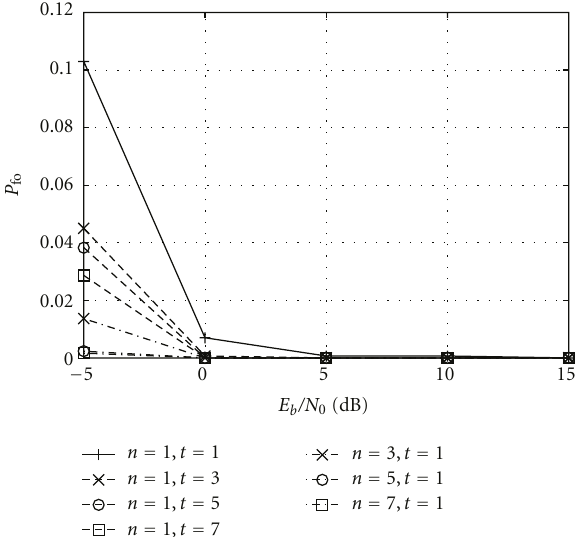
Figure 8: Probability of false opportunity detection P fo versus energy per bit to noise power spectral density ratio E b /N 0 for di ff erent numbers n of cooperative single antenna CR terminals and multiple antenna CR terminal with a variable number t of antennas.